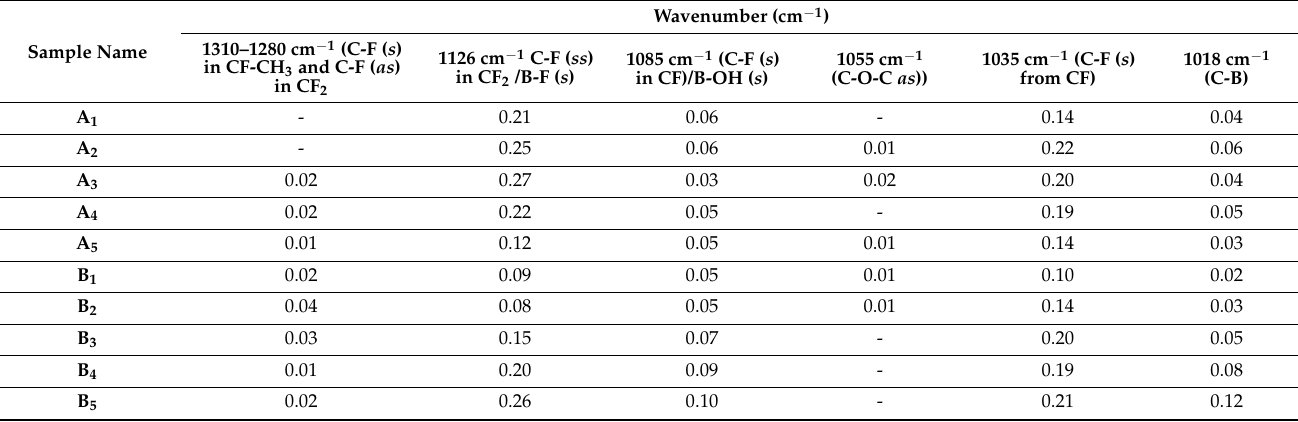
Table 4. The areas of the peaks derived from groups containing in their structure atoms of fluorine and boron.